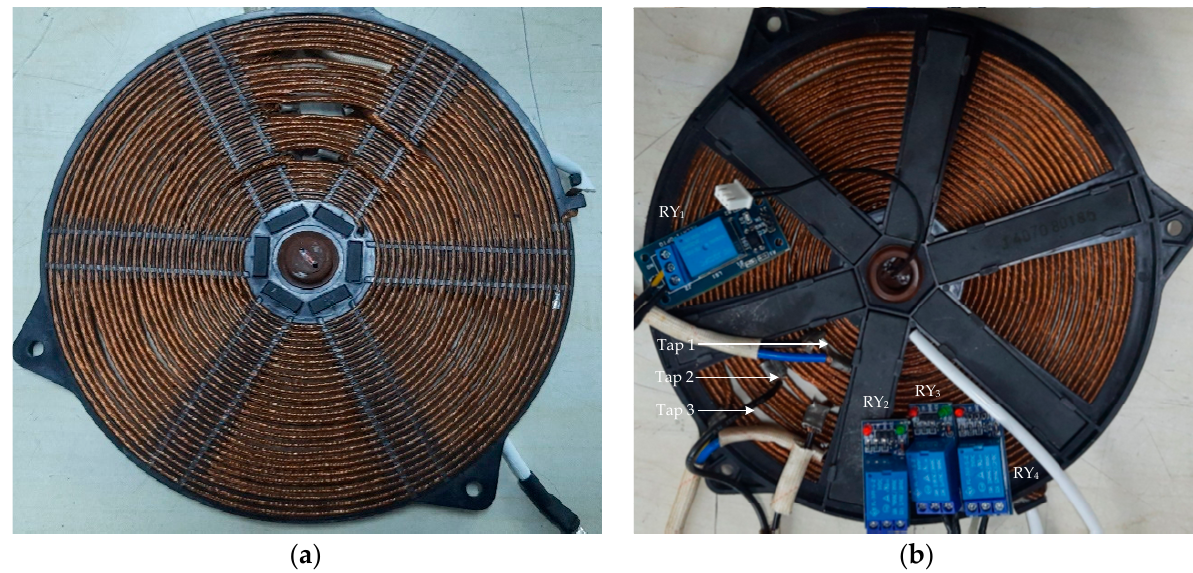
Figure 8. Multi ‐ tapped induction coil: ( a ) top view; ( b ) bottom view.